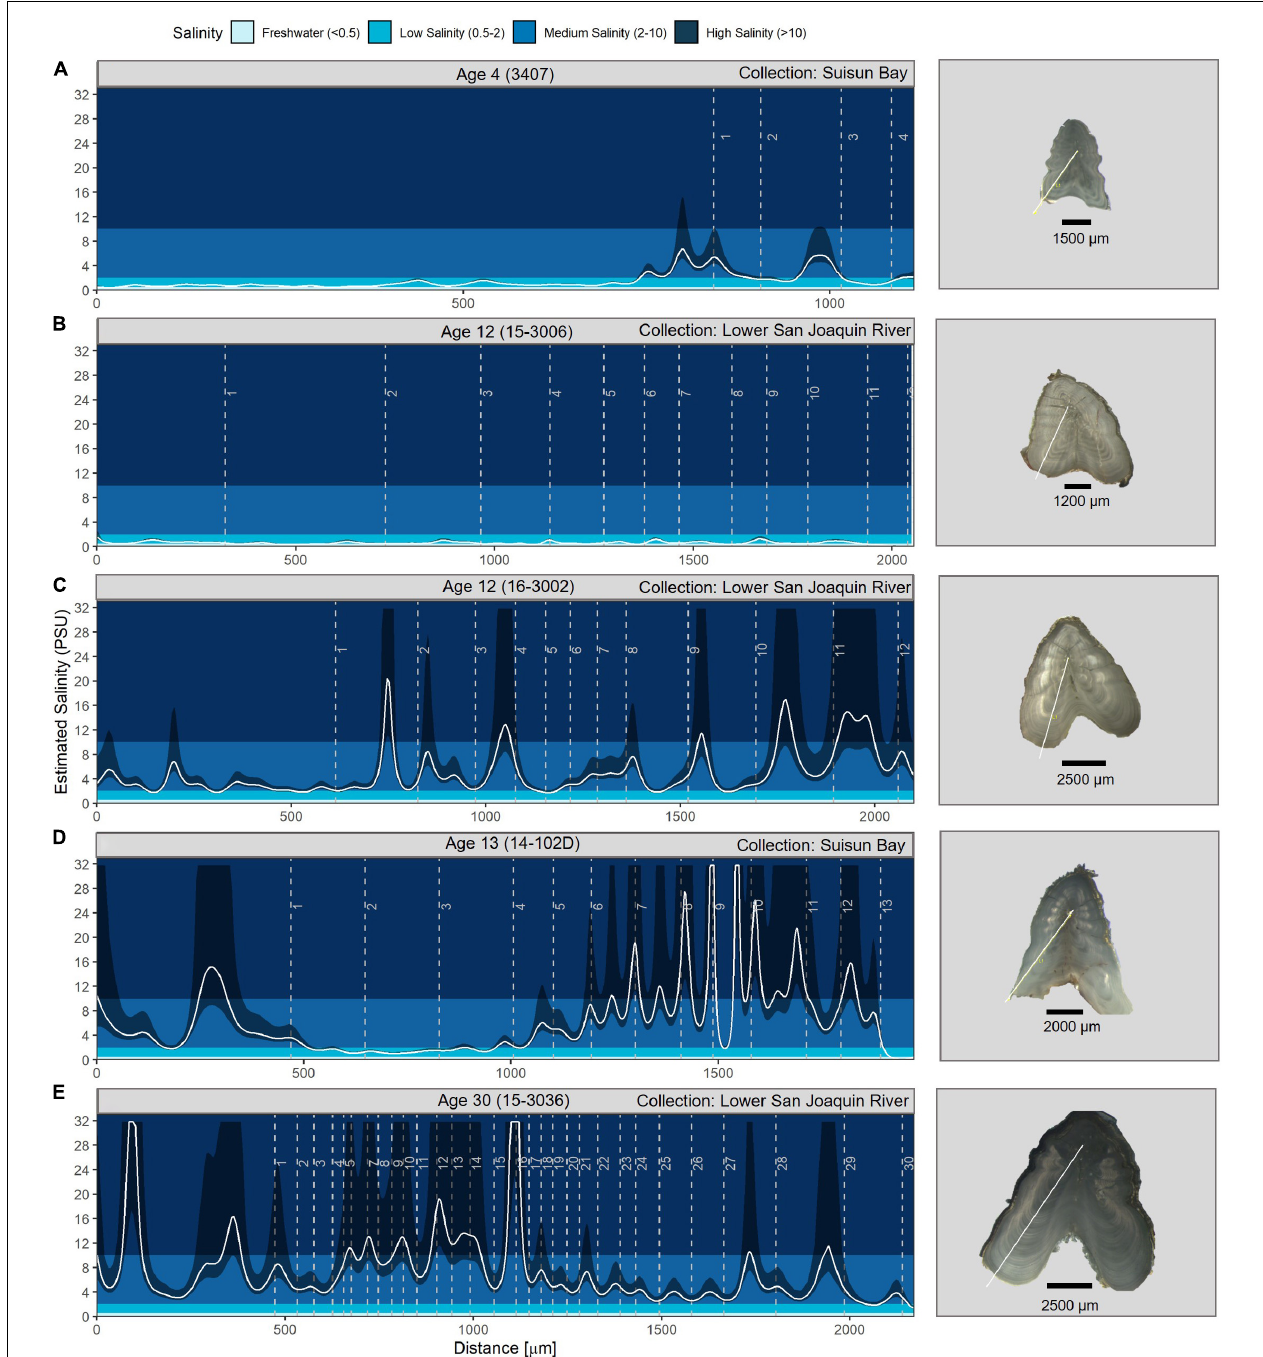
FIGURE 5 | Salinity profile examples showing variability in use of different salinity habitats across a range of ages. The white line is the salinity spline, and the dark shaded area is the associated estimated uncertainty. Note patterns at higher salinity values are less certain due to the non-linear nature of the mixing curve ( Figure 3 ). Dashed vertical age lines represent the opaque (summer) portion of the annuli. Note the x -axis range varies among different plots because of fish age and because fin ray sections were cut from different fin ray regions across individual fish. The fish ID is shown at the top of each graph and links to the Supplementary Table 1 . Profiles for all fish are shown in Supplementary Figure 1 and annual average salinities for each fish are in Supplementary Figure 2 . An image of each fin ray section is included to the right of each figure to provide a representation of size variability. The white line on the fin rays shows the location of the geochemistry transect. Fin ray images were taken by Shannon Blackburn. (A) is the youngest fish sampled, (B) resided in predominantly fresh- or low-salinity water (B) , (C) made short high salinity excursions, (D) exhibited early migration to higher-salinity brackish water, and (E) is the oldest fish sampled.